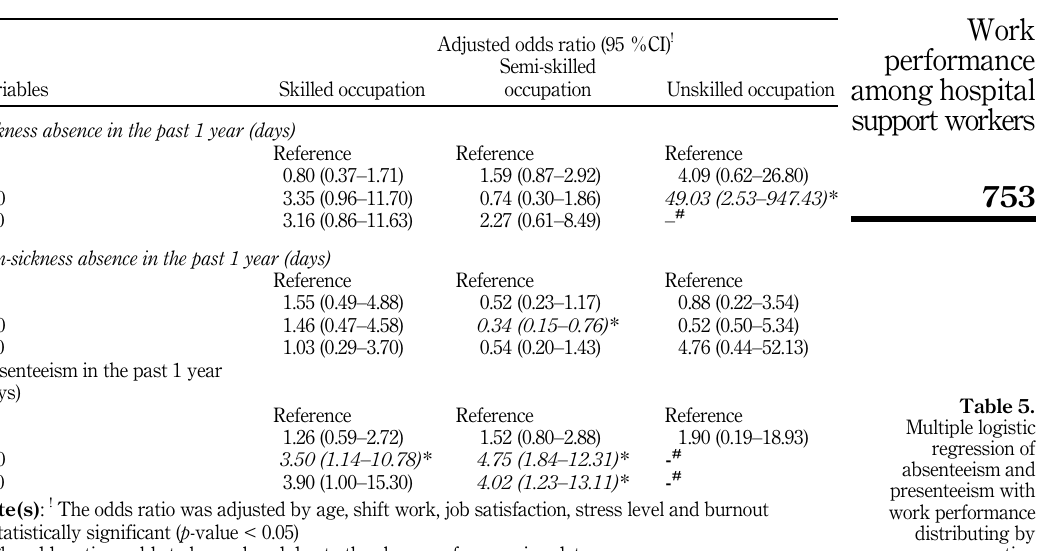
regression of absenteeism